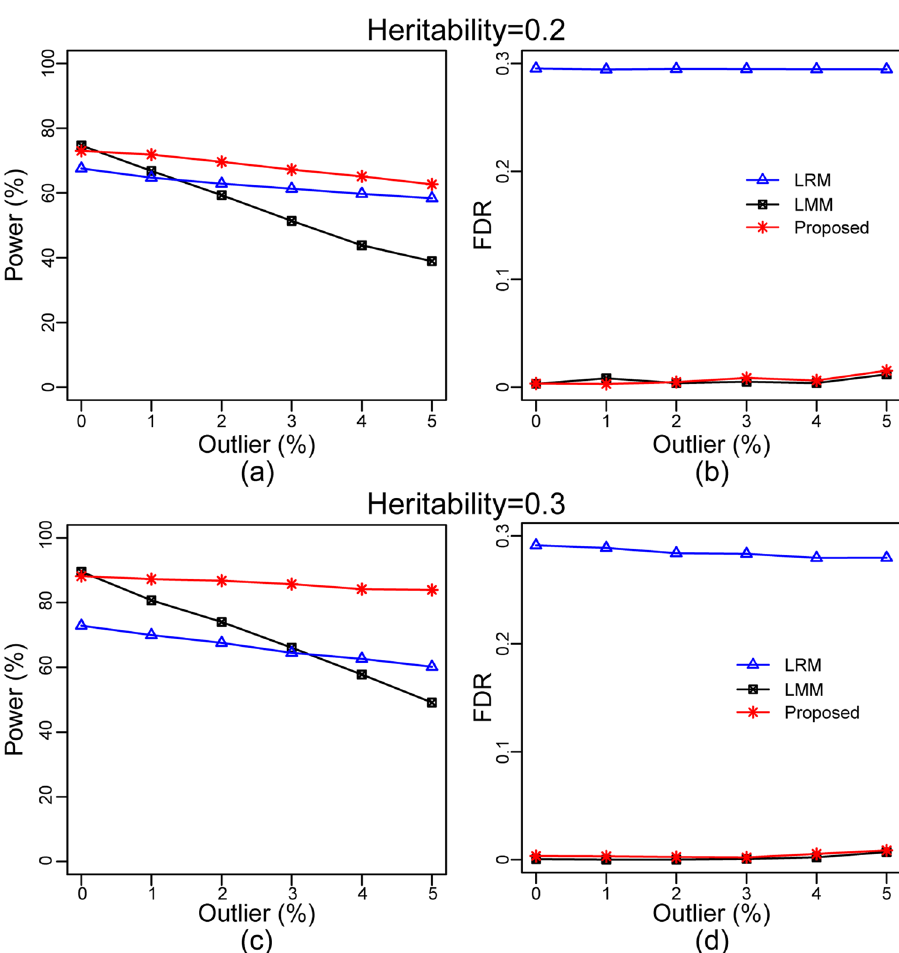
Figure 1. Results computed by LRM, LMM and the proposed methods based on complete simulation ( a ) plot of statistical power against the rate of phenotypic outliers at heritability h 2 = 0.2 and at the cutoff p -value 10 –5 . ( b ) Plot of FDR against the rate of phenotypic outliers at h 2 = 0.2 and at cutoff = 10 –5 . ( c ) plot of statistical power against the rate of phenotypic outliers at h 2 = 0.3 and cutoff 10 –5 ( d ) plot of FDR against the rate of phenotypic outliers at h 2 = 0.3 and cutoff 10 –5